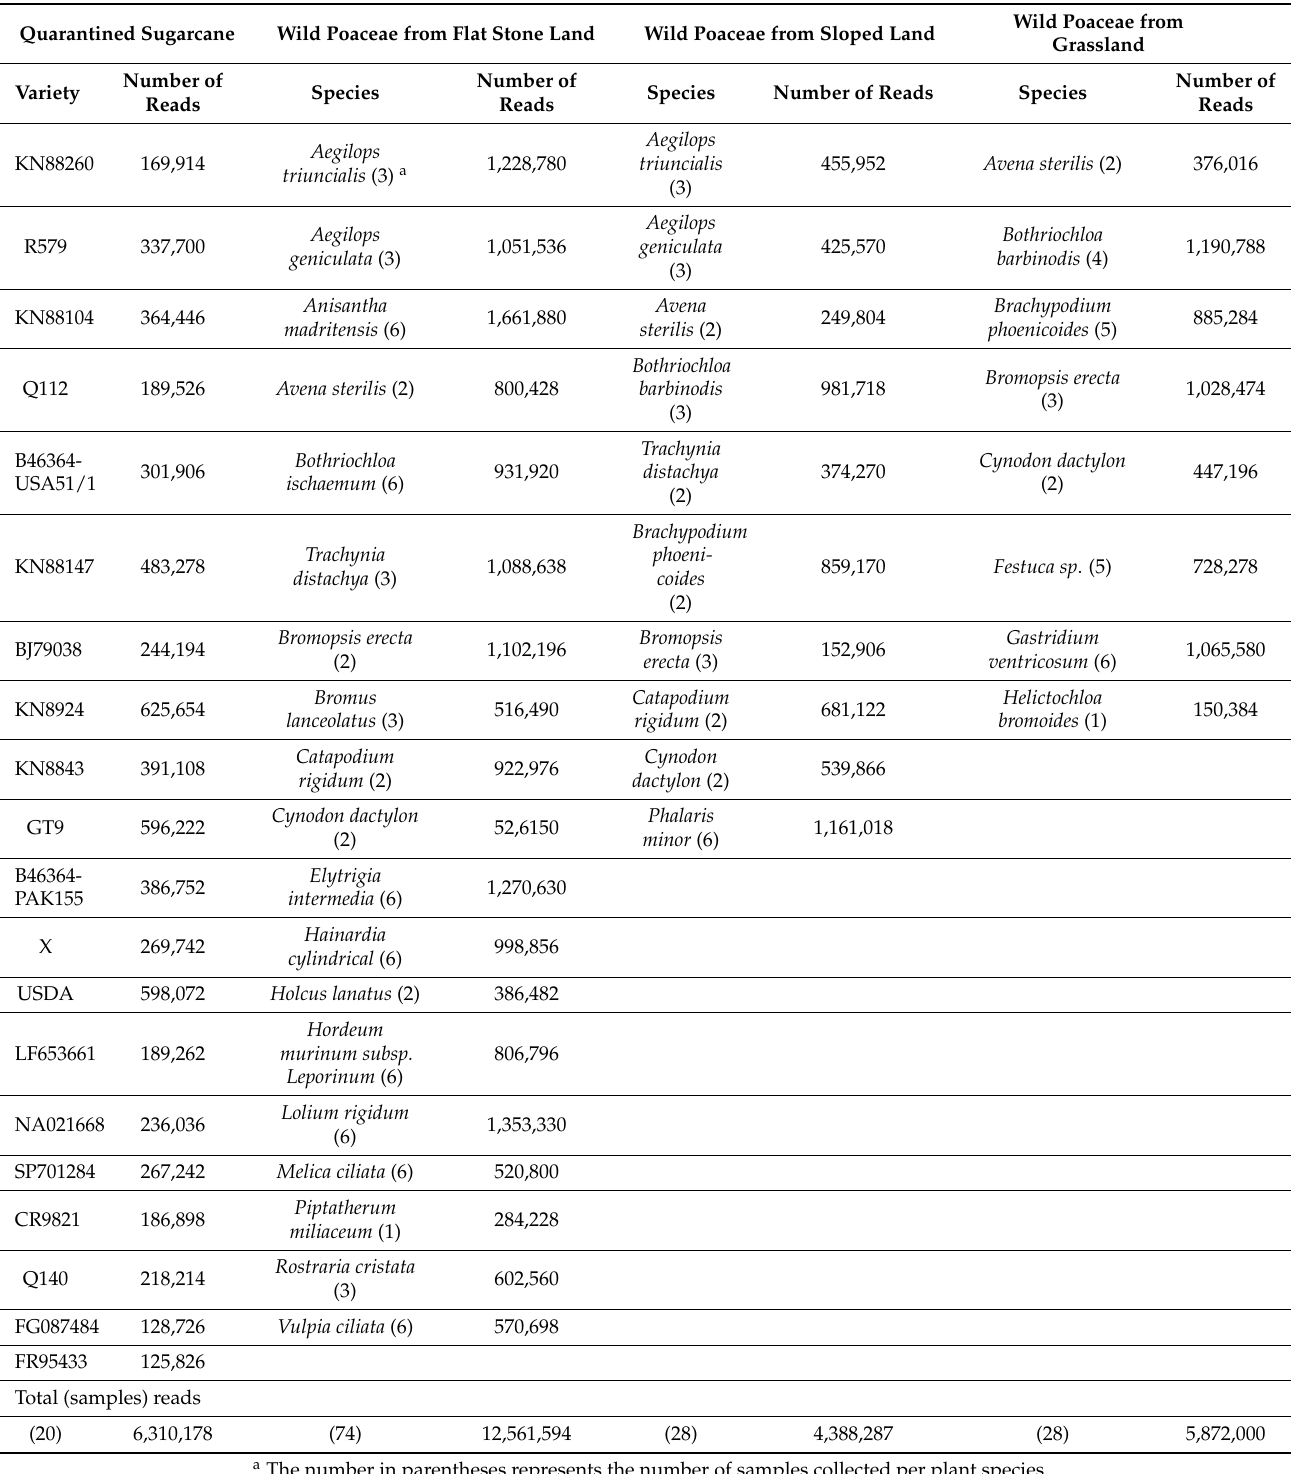
Table 1. List of plant samples processed by virion-associated nucleic acid metagenomics and number of reads obtained for each